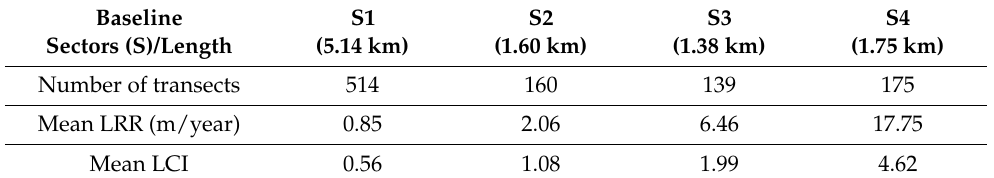
Table 4. Multitemporal statistical rates for the 1945–2016 period based on LRR